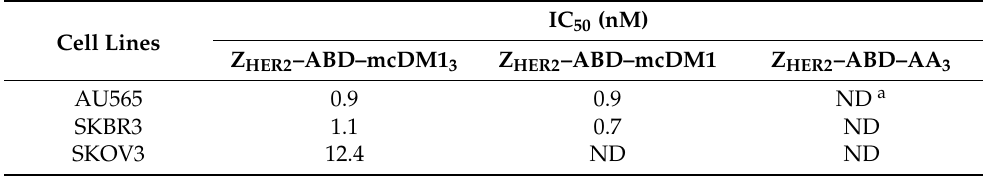
Figure 4. The conjugates’ cytotoxic potential in vitro. The cell lines’ relative viability was determined and plotted against the concentration of the added AffiDCs or the non-toxic control. The half maximal inhibitory concentration (IC 50 ) values were determined from the plots when the cells’ relative viability was 50% that of the untreated cells (which was set to 100%). Each concentration was tested in quadruplicate wells, and the mean value is plotted with error bars corresponding to 1 standard deviation (SD). Table 2. The conjugates’ cytotoxic potential in